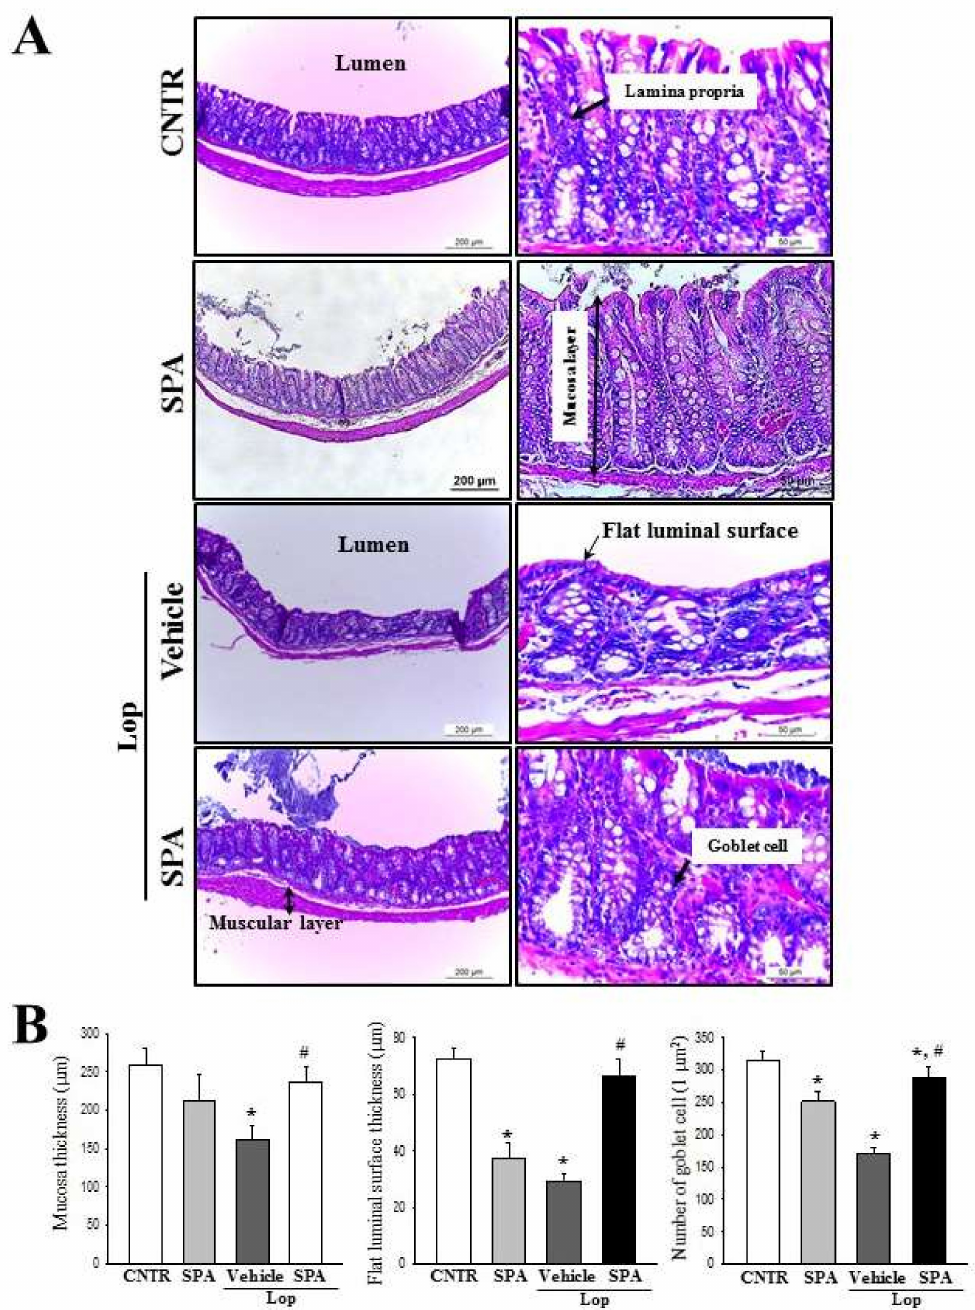
Figure 3. The histological structures of the colons in Lop-induced constipated rats after SPA administration: ( A ) The hematoxylin and eosin (H&E)-stained sections of the colon from the CNTR, SPA-, Lop + Vehicle- or Lop + SPA-treated group were observed at 100 × (left column) and 200 × (left column) using a light microscope.( B ) The histopathological parameters were determined using the Leica Application Suite (Leica Microsystems). Five to six rats per group were used in the histological analysis, and each parameter was measured in duplicate in two different slides. The data are reported as the mean ± SD. * indicates p < 0.05 compared to the CNTR group. # indicates p < 0.05 compared to the Lop + Vehicle-treated